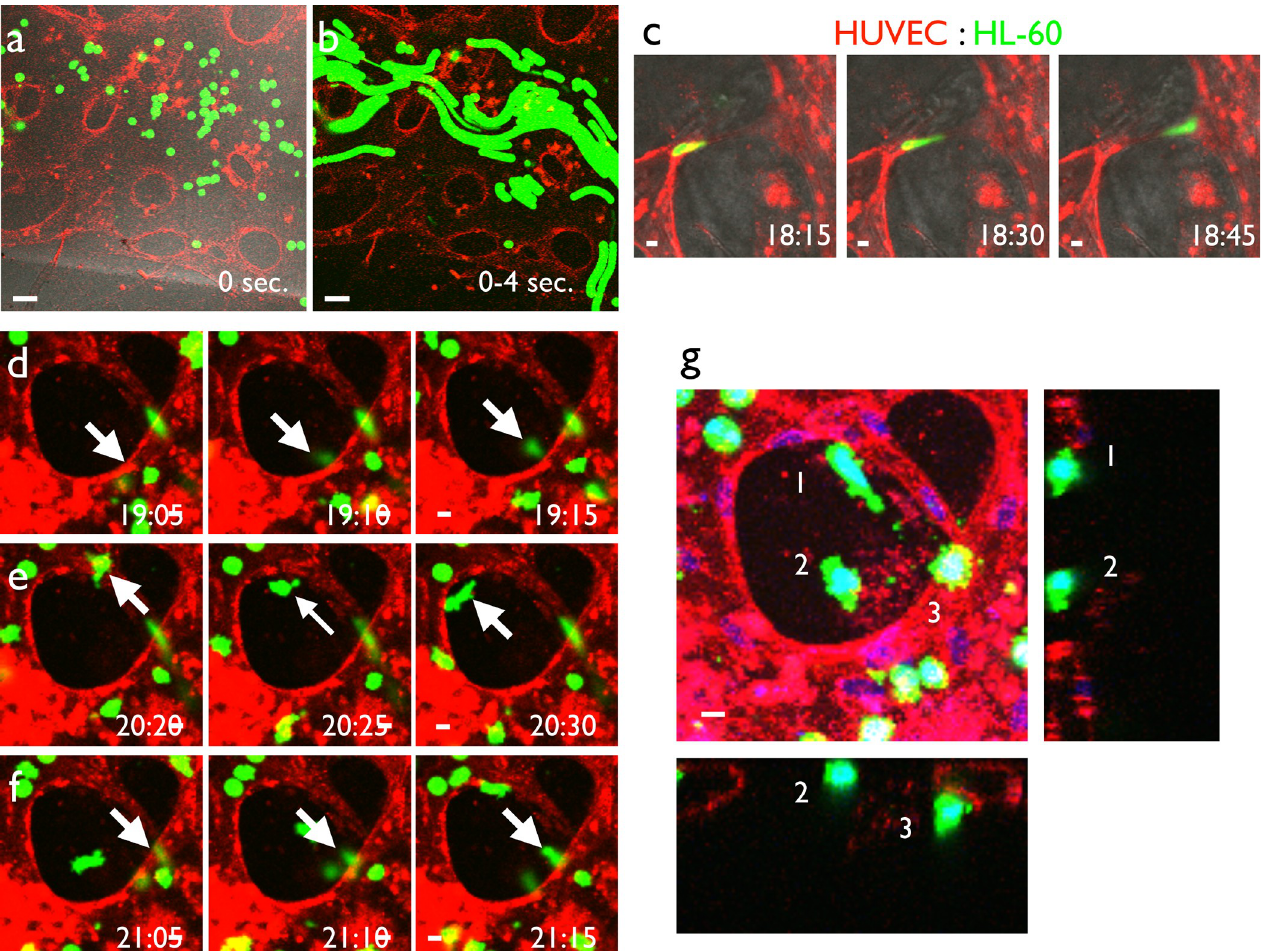
Fig 6. Extravasation of leukocytes using the self-organized vascular network. (a) HL-60 cells, an acute myelogenous leukemia cell line, were labeled with CellTracker Green and introduced into the self-organized vascular system visualized by UEA-I lectin. (b) Projection image of a time-lapse movie for 4 seconds. Movement of HL-60 cells inside the vascular network was observed. (c) DMSO-induced differentiated HL-60 cells (dHL-60), which mimicked neutrophils, passed through thin vessels with large deformation under the presence of TNF α . (d–f) Representative time-course of extravasation. Extravasation occurred within a short time period (10 min.). Extravasating cells (white arrows) extended protrusions toward the outside of the blood vessel when emigrating from the blood vessel lumen. (g) Three-dimensional structure of extravasated cells (white arrows) shown as max projection x-y and x-z/y-z single slice images. We clearly observed extravasated cells outside of the vasculature. Time separated with colons indicates hours and minutes. Scale bars: 50 μ m (a, b); 10 μ m (c–g).